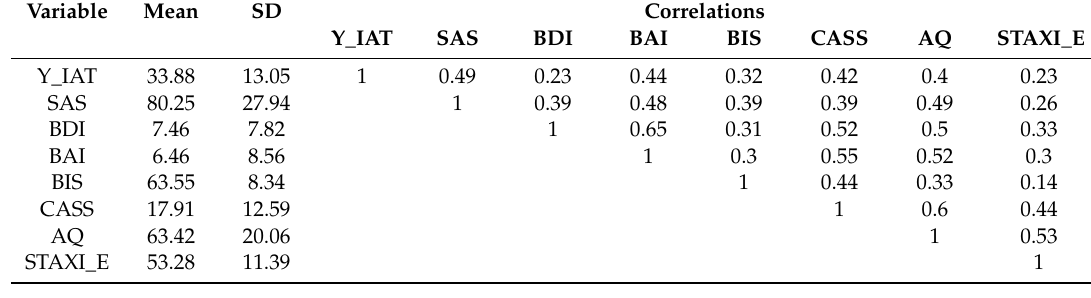
Table 1. Descriptive statistics of addiction and psychosocial measures.